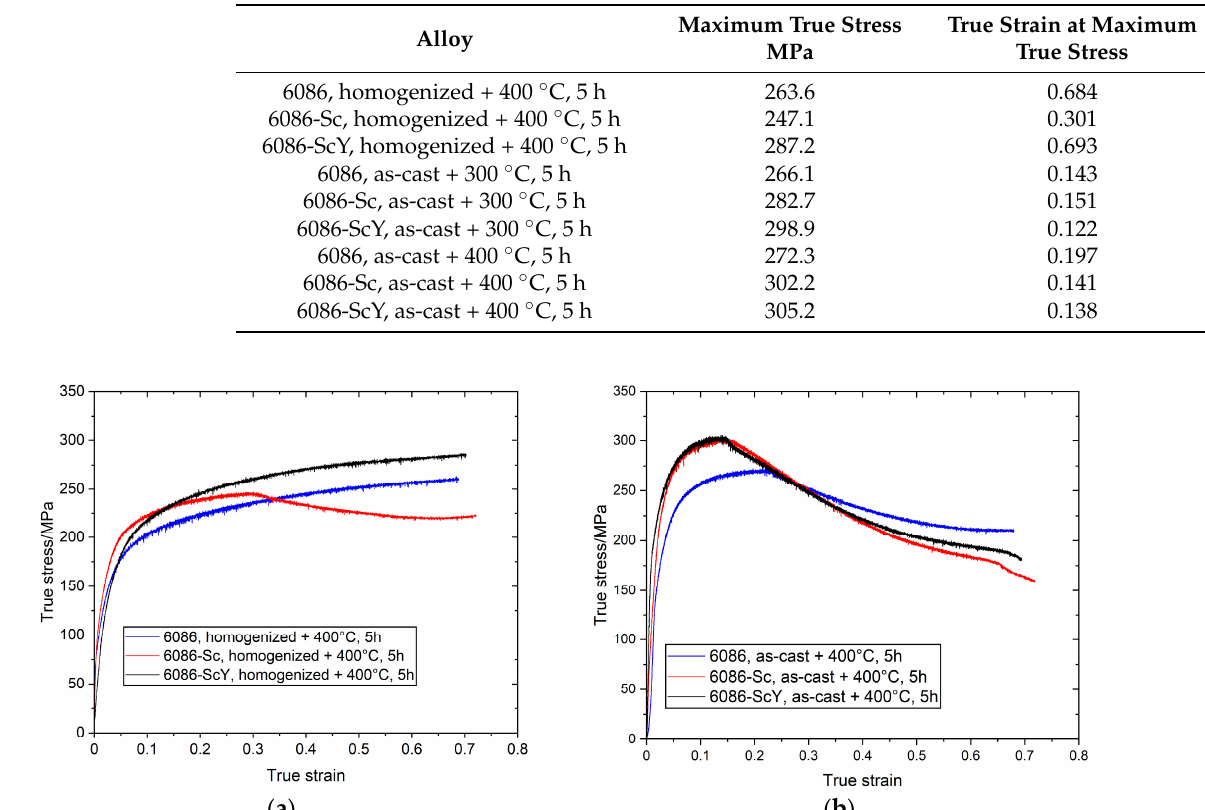
Table 2. Results of the compression tests.